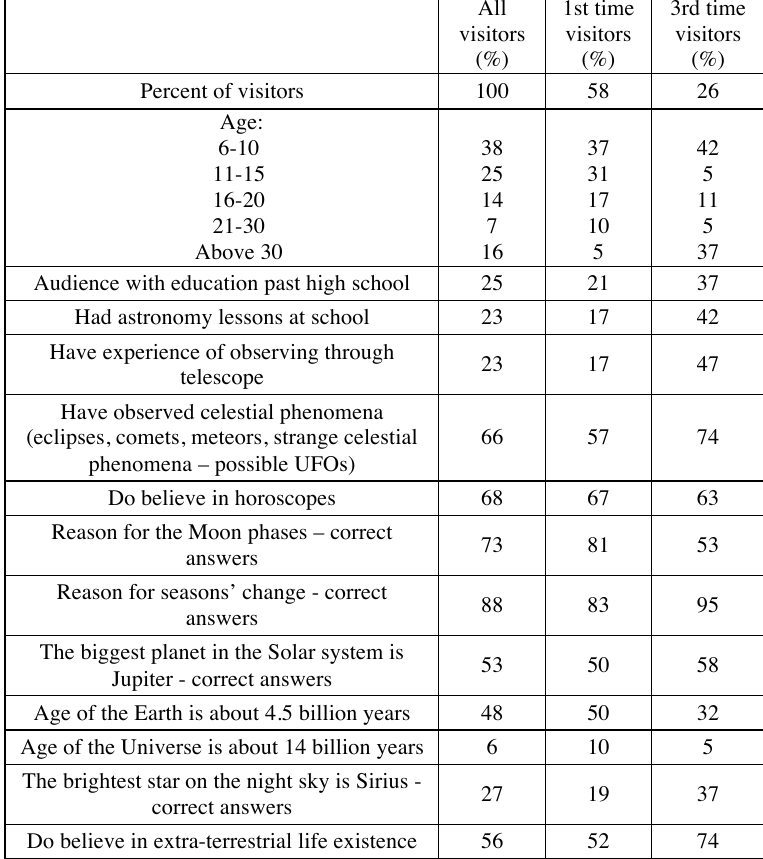
Table 1. Results of the audience